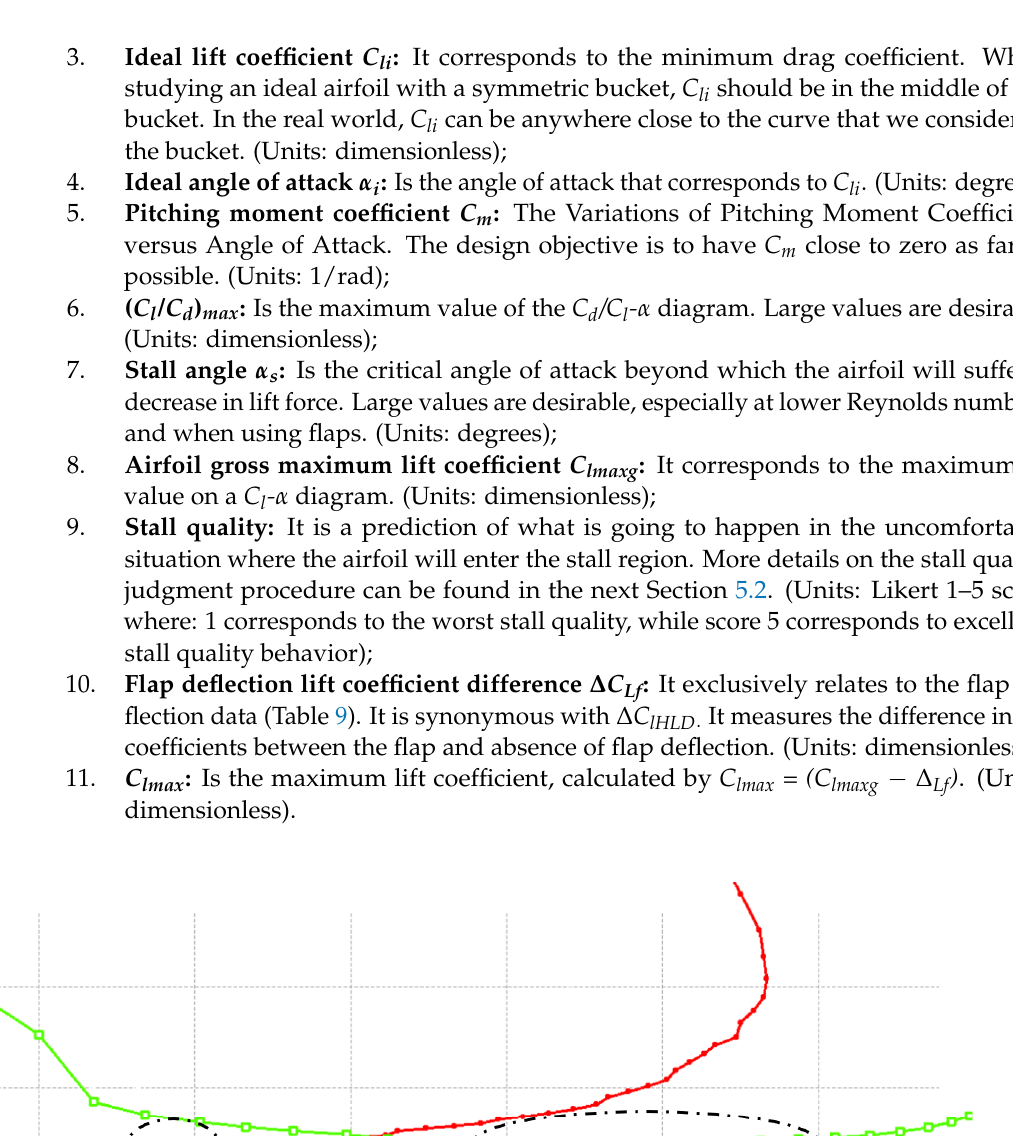
Figure 7. A way to quantify the stall quality. Figure 7 represents an ideal C l - α diagram. Left part contains α s and C lmax points. Further to the right than the critical a s point, three hypothetical stall curves are displayed. Obviously, the preference is green > orange > red. We consider a vertical line at distance Δ x from the α s